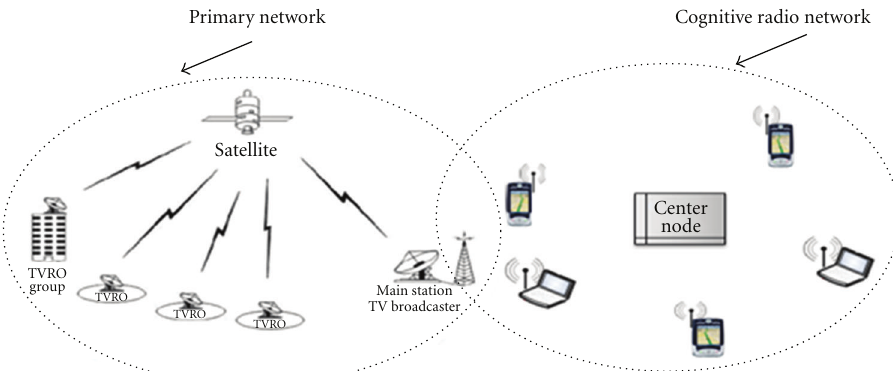
Figure 1: An example of a centralized CR network.